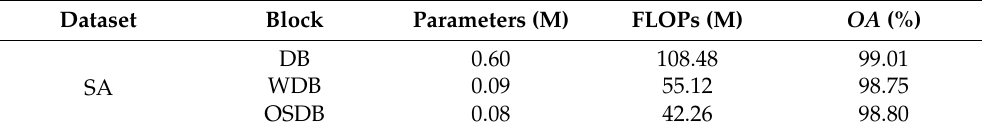
Table 21. The number of parameters, FLOPs, and OA of different dense blocks on the SA dataset. Dataset